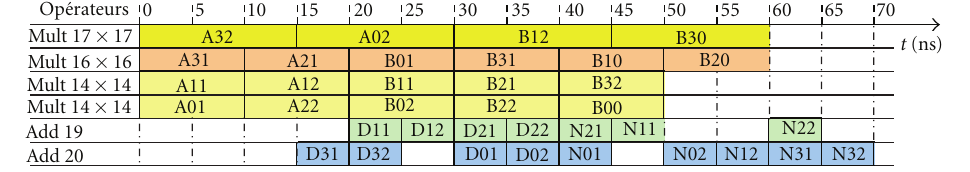
Figure 8: Scheduling of the 8th-order IIR filter obtained for the second